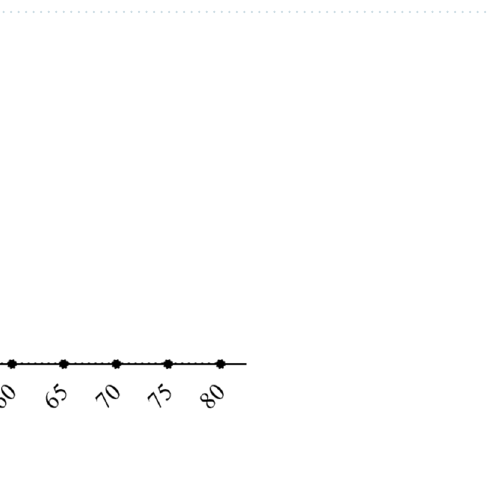
Figure 3. ( a ) Fluorescence intensity derived from Calcofluor White staining for control assay and fucosidase (FU; ID 46) treatment. No statistical differences were observed ( p = 0.195). ( b ) and ( c ) fluorescence images (× 400) of Laminaria digitata suspension stained with Calcofluor White for control assay and fucosidase treatment, respectively.